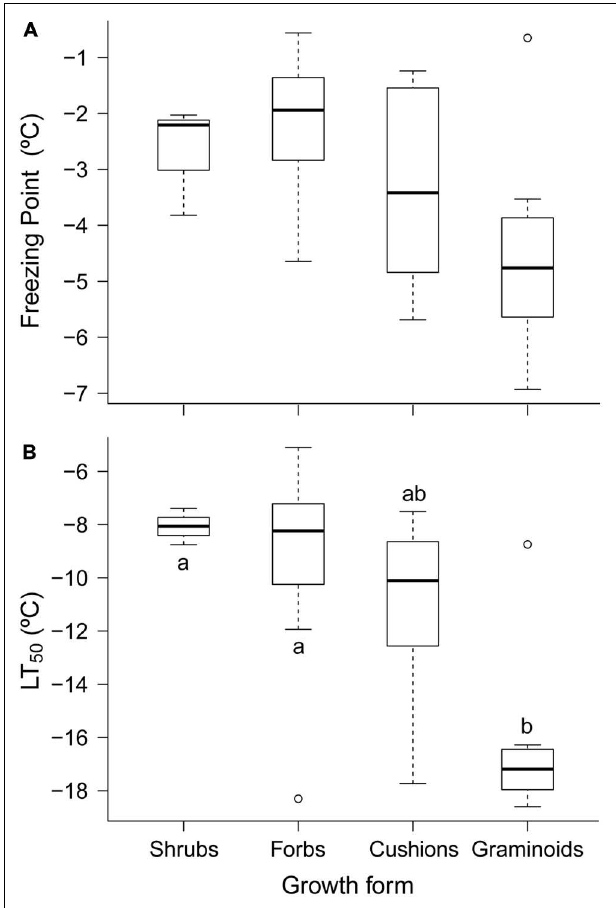
FIGURE 2 | Summer freezing resistance measured in the leaves of 42 species and grouped by growth form: (A) freezing point (FP, ◦ C) and (B) freezing temperature damage (LT 50 , ◦ C). Each box plot shows the median (solid line), interquartile range (box enclosure), variability outside the upper and lower quartiles, which is no more than 1.5 times the length of the box away from the box (extreme “ whisker” ), and outliers (black points). Pairs of box plots labeled with different letters above the “ whisker ” differ significantly ( P < 0.05). Significant differences were evaluated using a post hoc Nemenyi test within each growth